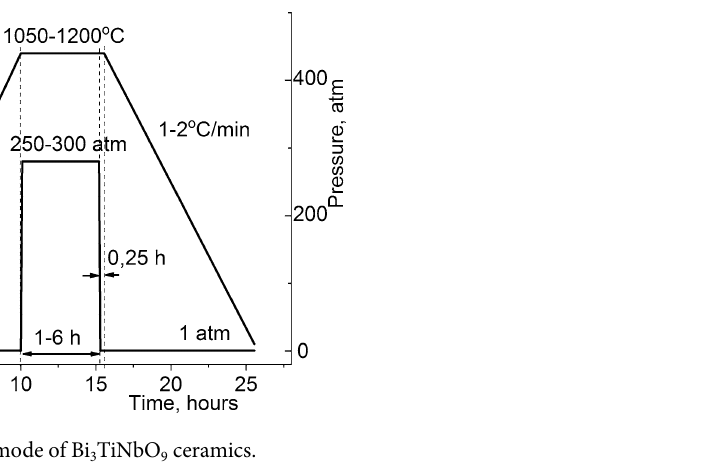
Figure 1. Hot pressing mode of Bi 3 TiNbO 9